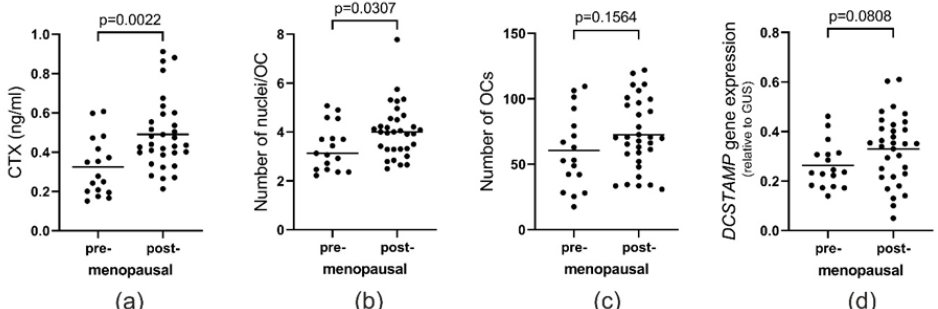
Figure 7. Menopause not only increases bone resorption in vivo, but also the number of nuclei per OC in vitro. Comparison between pre- and postmenopausal women regarding ( a ) the level of CTX in vivo, ( b ) the mean number of nuclei per OC in vitro, ( c ) the mean number of OCs (per vision field) in vitro, and ( d ) the gene expression level of DC-STAMP in OCs. Statistics: t -test in ( a , c , d ) and Mann– Whitney test in ( b ). Horizontal lines display the mean in ( a , c , d ) and the median in ( b ). Each point represents the results obtained from OCs generated from an individual donor ( n = 49).